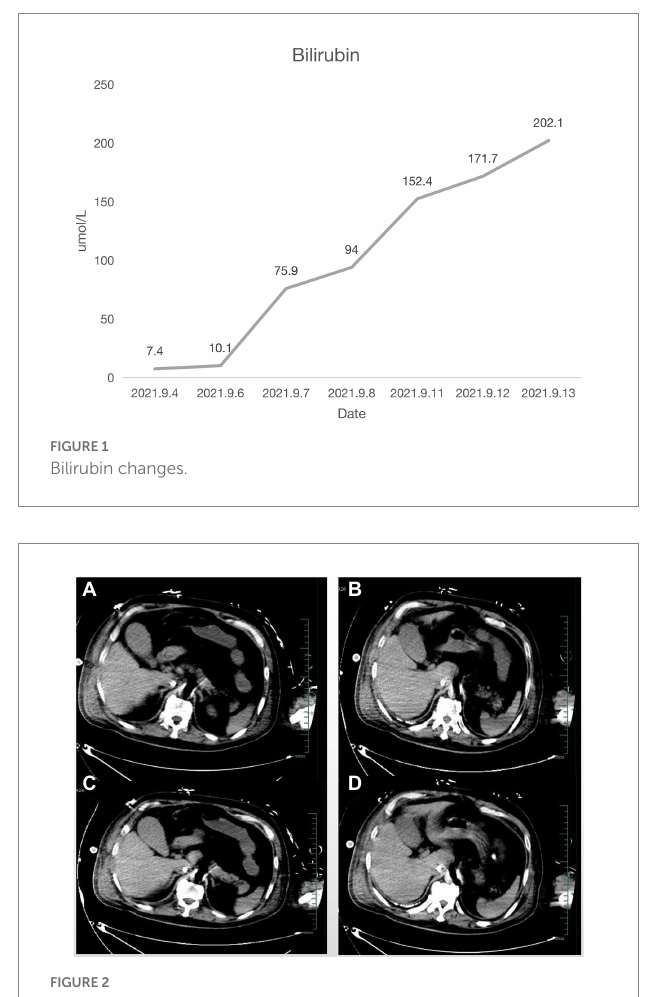
FIGURE 2 The abdominal computed tomography (A–D) levels showed no significant abnormality of the